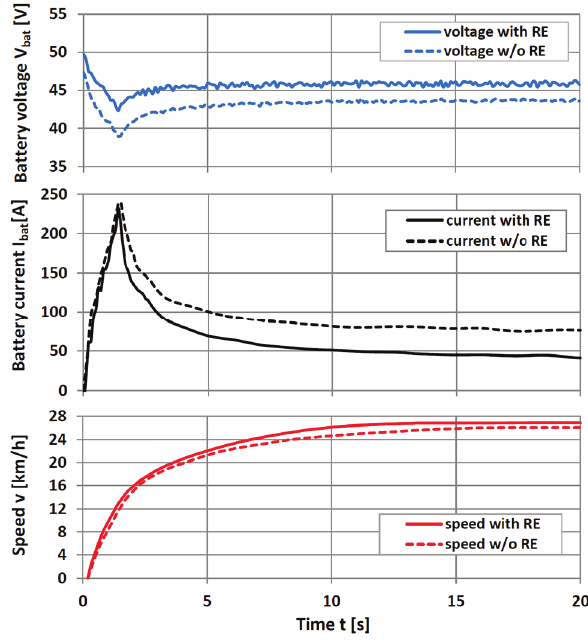
Fig. 13. Comparisons of battery parameters and vehicle speed during acceleration with the range extender off (dashed) and running